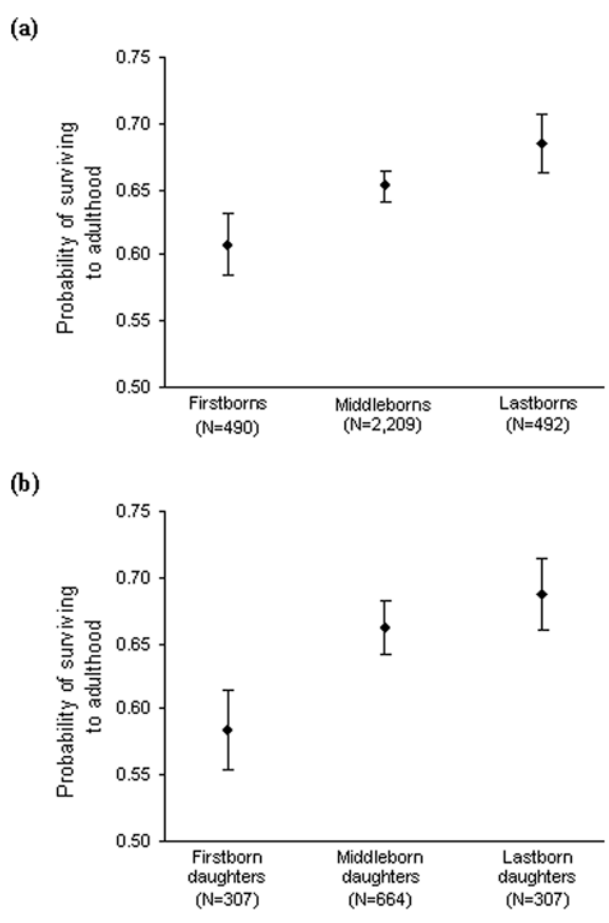
Figure 2. Probability of surviving to adulthood (age 15). (a) As a function of overall birth-order category: the probability of surviving to adulthood was marginally significantly influenced by whether an individual was a firstborn, middleborn or lastborn among all offspring ( x 2 2 =5.76, p =0.056). (b) As a function of intra-sex birth-order category (among daughters): the probability of surviving to adulthood was significantly influenced by whether a daughter was a firstborn, middleborn or lastborn ( x 2 2 =6.48, p =0.04). Figures show predicted values of the minimal model and error bars represent standard errors of the